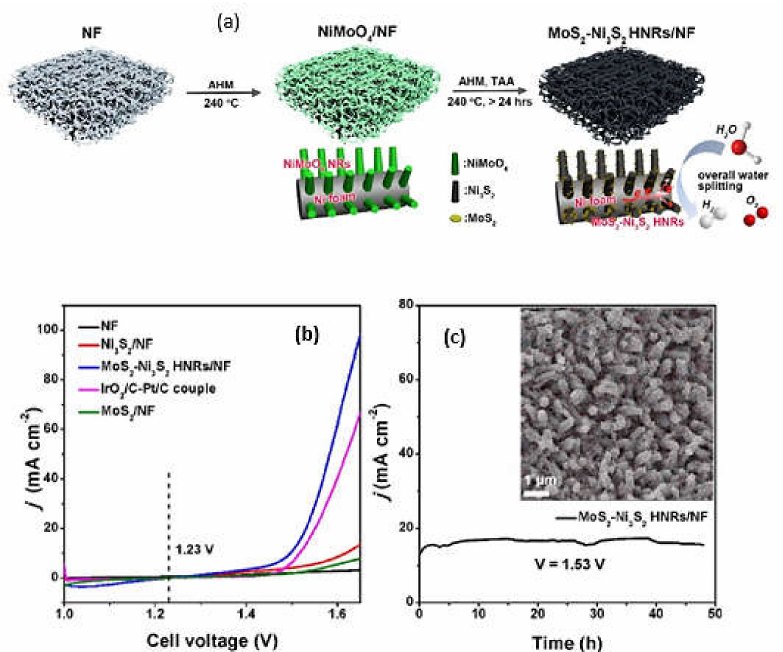
Figure 11. ( a ) Schematic representation of the fabrication of hetero-structured MoS 2 –Ni 3 S 2 HNRs/NF composites. ( b ) Polarization curves and ( c ) long-term durability tests at 1.53 V of MoS 2 − Ni 3 S 2 HNRs/NF for overall water splitting in a 1.0 M KOH solution. Inset: the SEM image of MoS 2 − Ni 3 S 2 HNRs/NF after water electrolysis for 48 h. Copyright 2017 by American Chemical Society